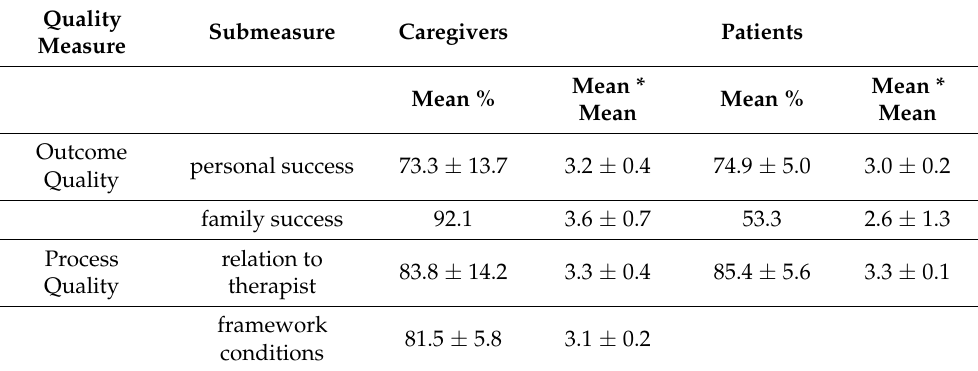
Table 3. Quality measures according FBB: percentage of categories 3 (mainly correct) and 4 (precisely correct) as well as the mean of the means of all ratings of patients ( n = 111) and caregivers ( n = 118). Quality Submeasure Caregivers Patients Measure Mean * Mean % Mean % Mean Mean Outcome personal Quality